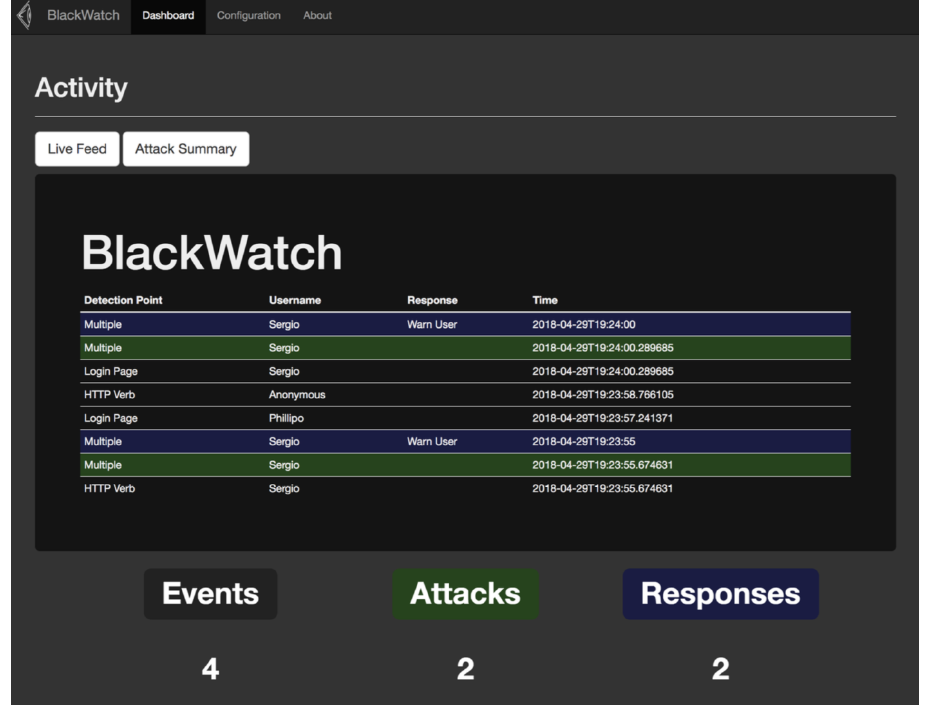
Figure 10. BlackWatch dashboard